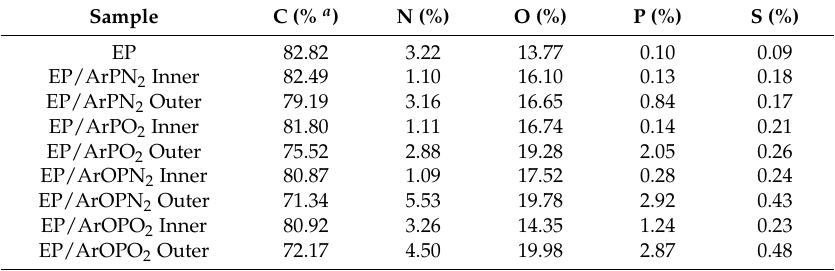
Figure 4. Macroscopic photos of cone calorimeter residue ( a ) and heat release rate (HRR) curves of EP and EP/polysulfone composites ( b ). Table 4. X-ray photoelectron spectroscopy (XPS) results of the residual char of EP and EP/polysulfone composites.